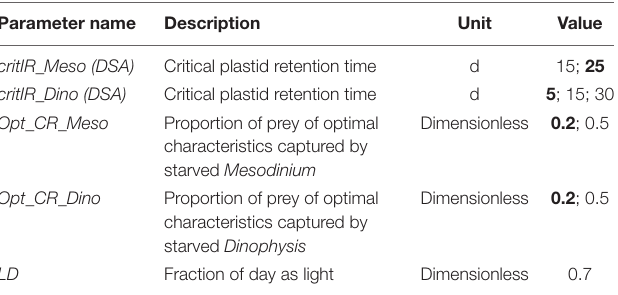
TABLE 3 | Abiotic parameters of the model. Numbers in bold are the values used by default in the simulations ( Figures 3–8 ); others are those tested in the dynamic risk analysis ( Supplementary Data Sheet 1 Figure S1 ; see also Table 4 ).